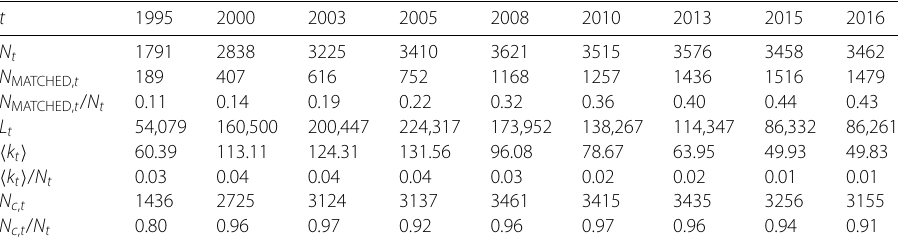
Table 6 Global statistical properties of the insider network calculated on January 1st in a corresponding year t . The years were selected in order to illustrate network properties over the whole span of the SRD data as well as SIRE insider trade data set collection periods (see Fig. 1). Here, N t denotes the number of nodes, N MATCHED, t – number of matched insiders, N MATCHED, t / N t – ratio of matched insiders to all insiders in the network, L t – number of links, (cid:5) k t (cid:6) – average degree, (cid:5) k t (cid:6) / N t – normalized average degree N t , N c , t – number of nodes in the maximal connected component, N c , t / N t – fraction of nodes belonging to the maximal connected component